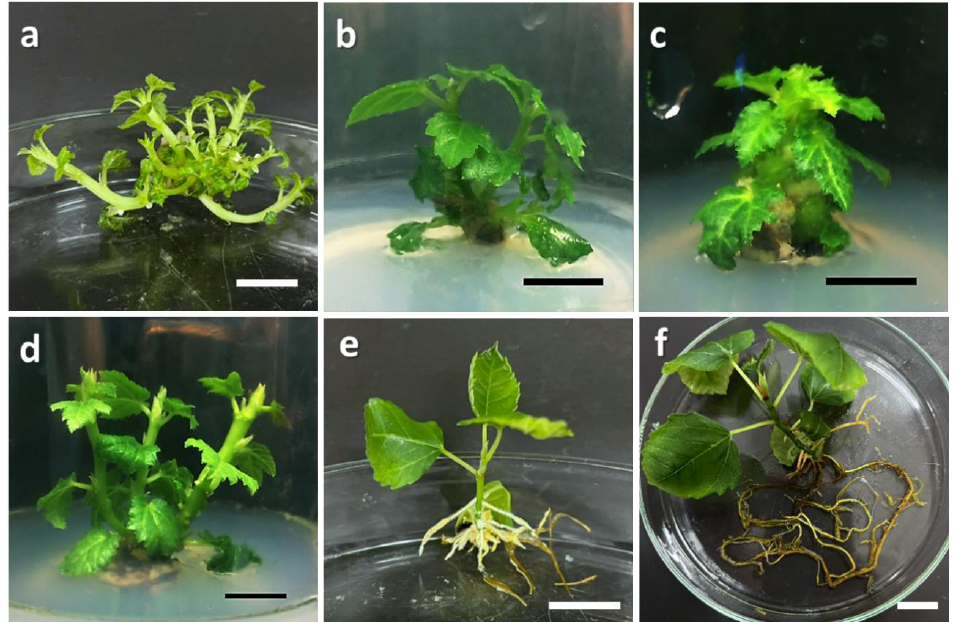
Figure 1. Shoot explant of Ficus carica cv. “ Violette de Solliès ” at different stages of microprop- agation: ( a ) multiple shoot induction in MS medium supplemented with 6.0 mg/L BAP; ( b ) multiple shoot induction in MS medium supplemented with 5.0 mg/L Kn; ( c ) multiple shoot induction in MS medium supplemented with 5.0 mg/L TDZ; ( d ) multiple shoot induction in MS medium supple- mented with 6.0 mg/L Zea; ( e ) root induction in WPM supplemented with 3.0 mg/L IBA; ( f ) root morphology prior to acclimatization in biochar soil. Scale bars = 1 cm.